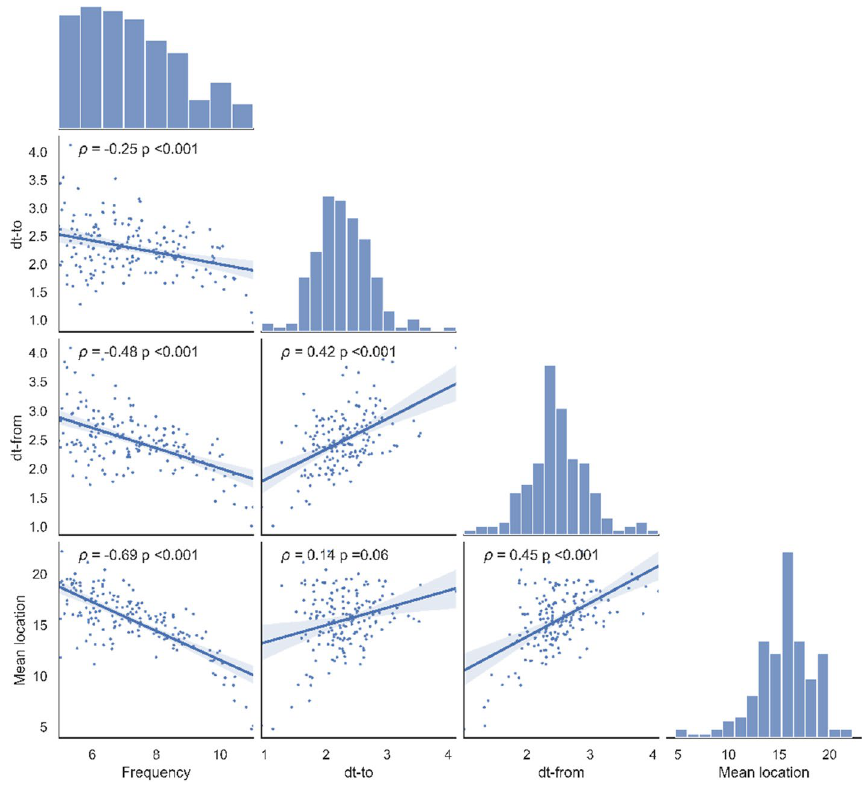
Fig. 10 Spearman correlation between log-frequency, the average location of a word, dt-from, and